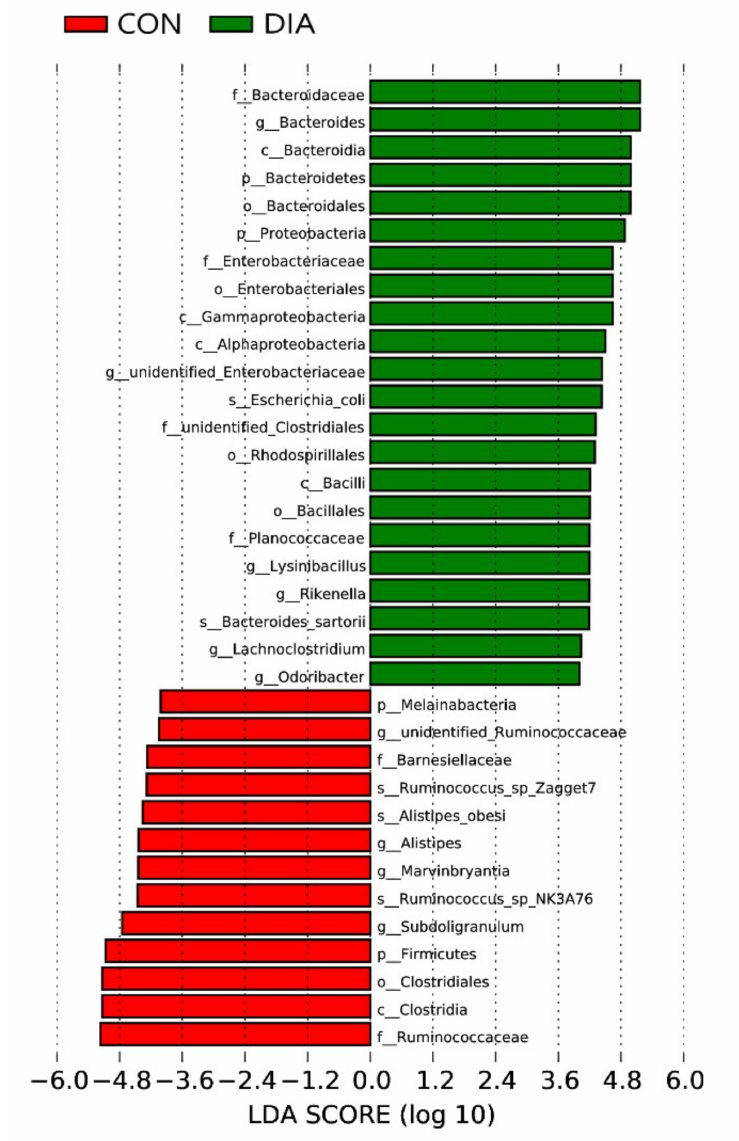
Figure 3. LDA score of